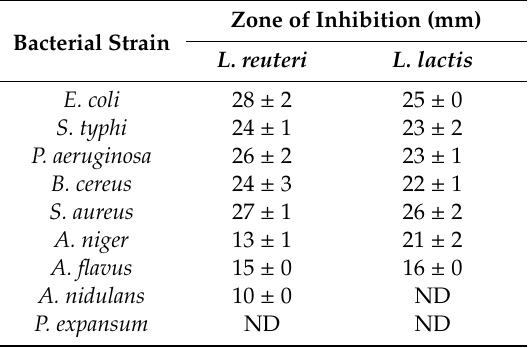
Table 2. Antimicrobial activity of Lactobacillus strains against bacteria and